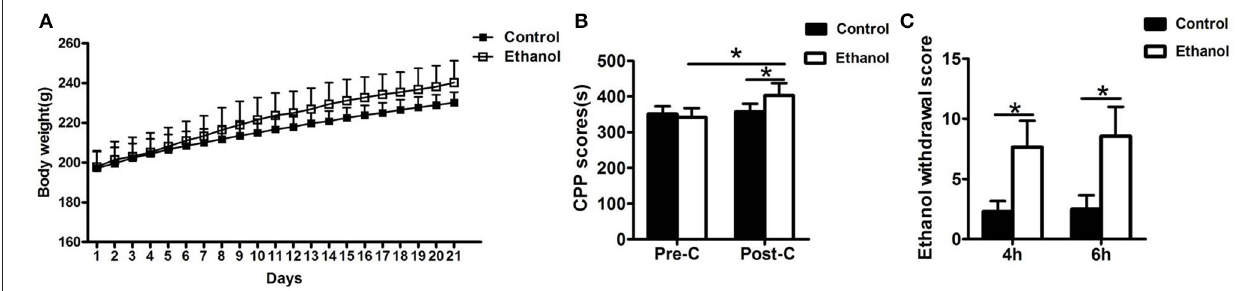
FIGURE 2 | Effects of ethanol dependence on body weight, conditioned place preference (CPP) and total ethanol withdrawal score at hours 4 and 6 of ethanol withdrawal. (A) The Ethanol group gained significantly more weight than the group; (B) The group exhibited no difference in the Pre-CPP; (C) The total ethanol withdrawal score. Data are as mean ± standard error. * P < 0.05 was